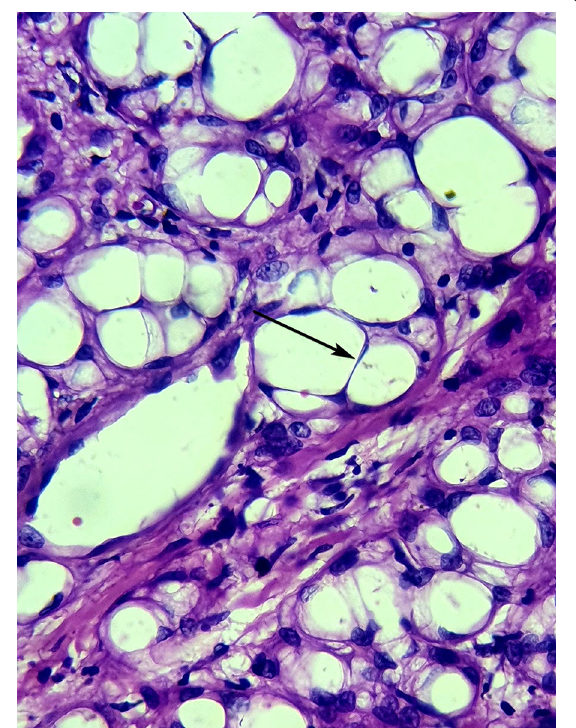
Fig. 3 Microscopic image: Prominent vacuolated cells with characteristic thread-like bridging strands (black arrow) (hematoxylin 40) and eosin stain × ×